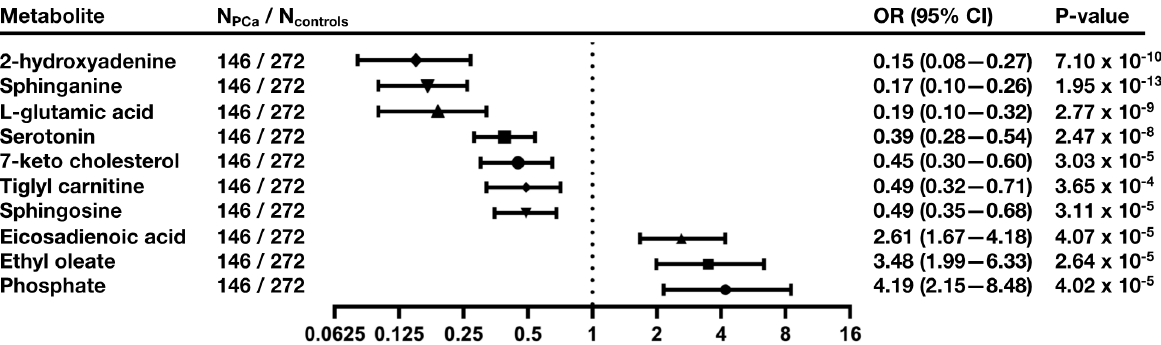
Figure 5. Relationship between baseline metabolites and risk of developing PCa during the follow-up. The x-axis represented log2 transformed scale. p-value from binomial logistic regression models, OR, odds ratio; CI, confidence interval .